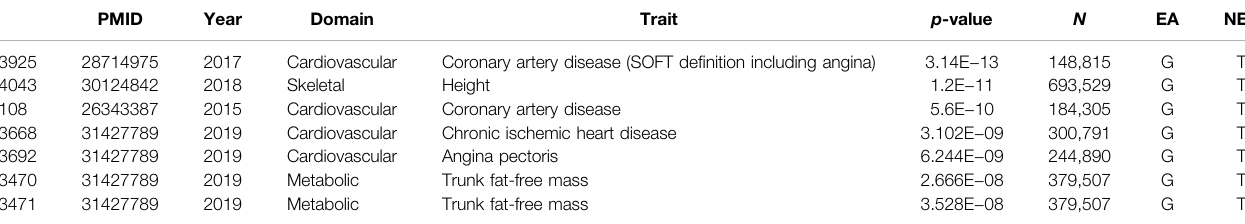
TABLE 2 | Lead genome-wide association studies from GWASATLAS for the SNP rs6738645 associated with CAD clinical traits